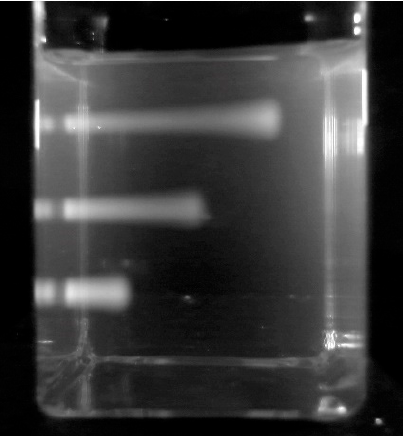
Figure 13. 80 MeV proton beam tracks imaged in a 40 × 40 × 40 mm 3 RFG gel; attenuated, from top to bottom, by polystyrene sheets 22, 32, and 42 mm thick. Portal dose 15 Gy.